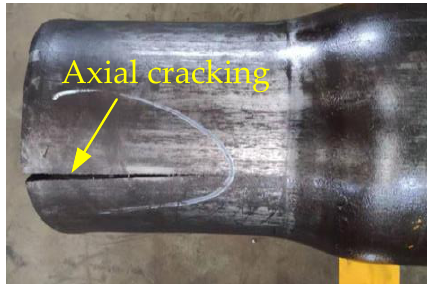
Figure 1. Axial cracking of reduced tube end.